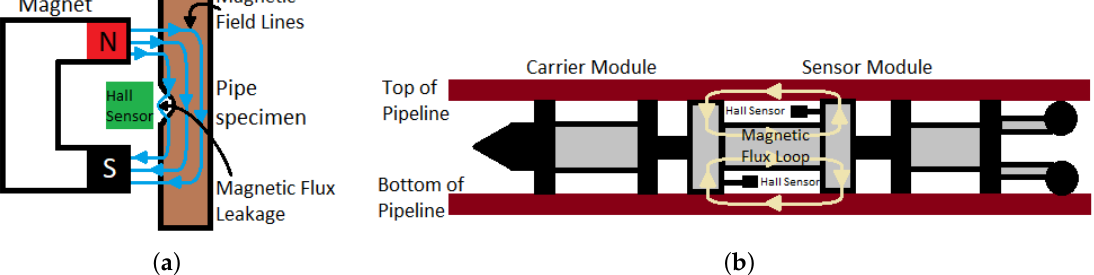
Figure 23. ( a ) Principle of MFL-based inspection for pipelines. ( b ) Layout of a circumferential MFL PIG. Modified from